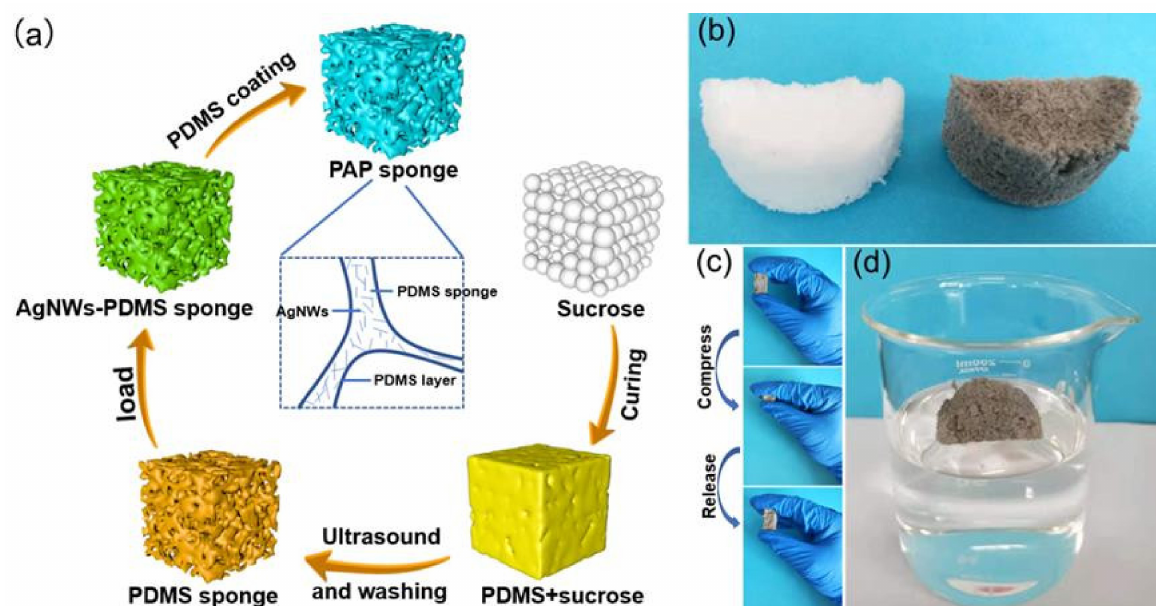
Figure 1. ( a ) Schematic illustration of the fabrication processes of PAP sponge. Digital photographs of ( b ) the PDMS sponge and PAP sponge, ( c ) the PAP sponge under a compressing and releasing cycle, and ( d ) the PAP sponge floating on the water